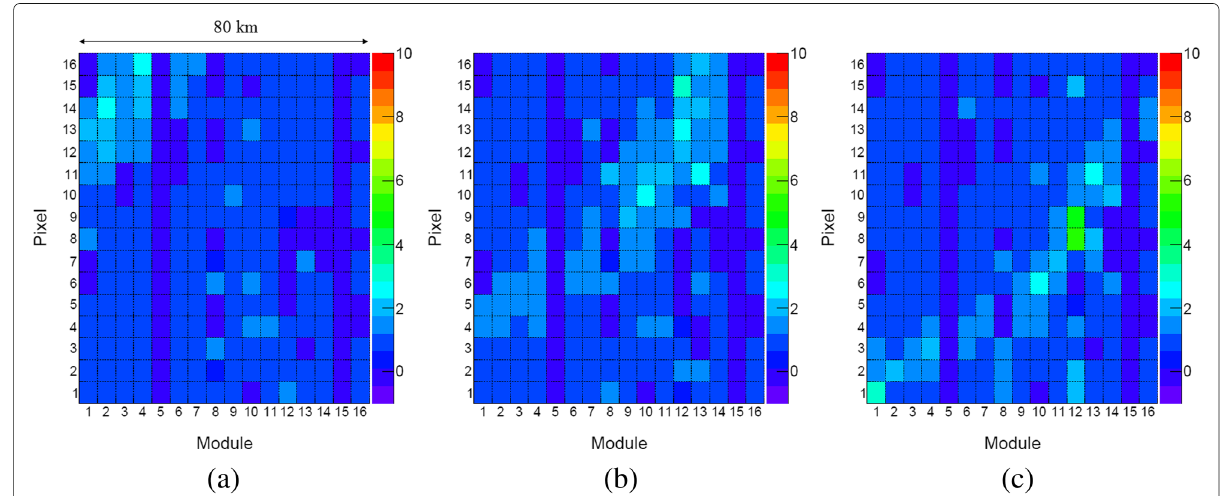
Fig. 2 Snapshots of the focal plane show arc-like shape and movement of the pattern through the detector’s field of view. The snapshots were taken at t = 0.077 ms ( a ), 0.174 ms ( b ), and 0.182 ms ( c ) from the beginning of the record. The signal amplitude is color coded in arbitrary units and scaled to individual PMT